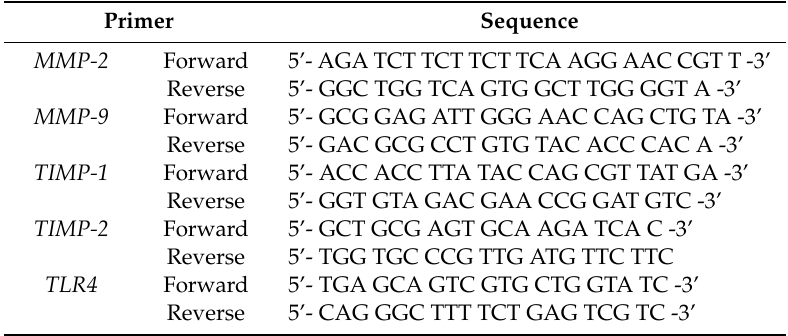
Table 1. Sequences of real-time PCR oligonucleotide